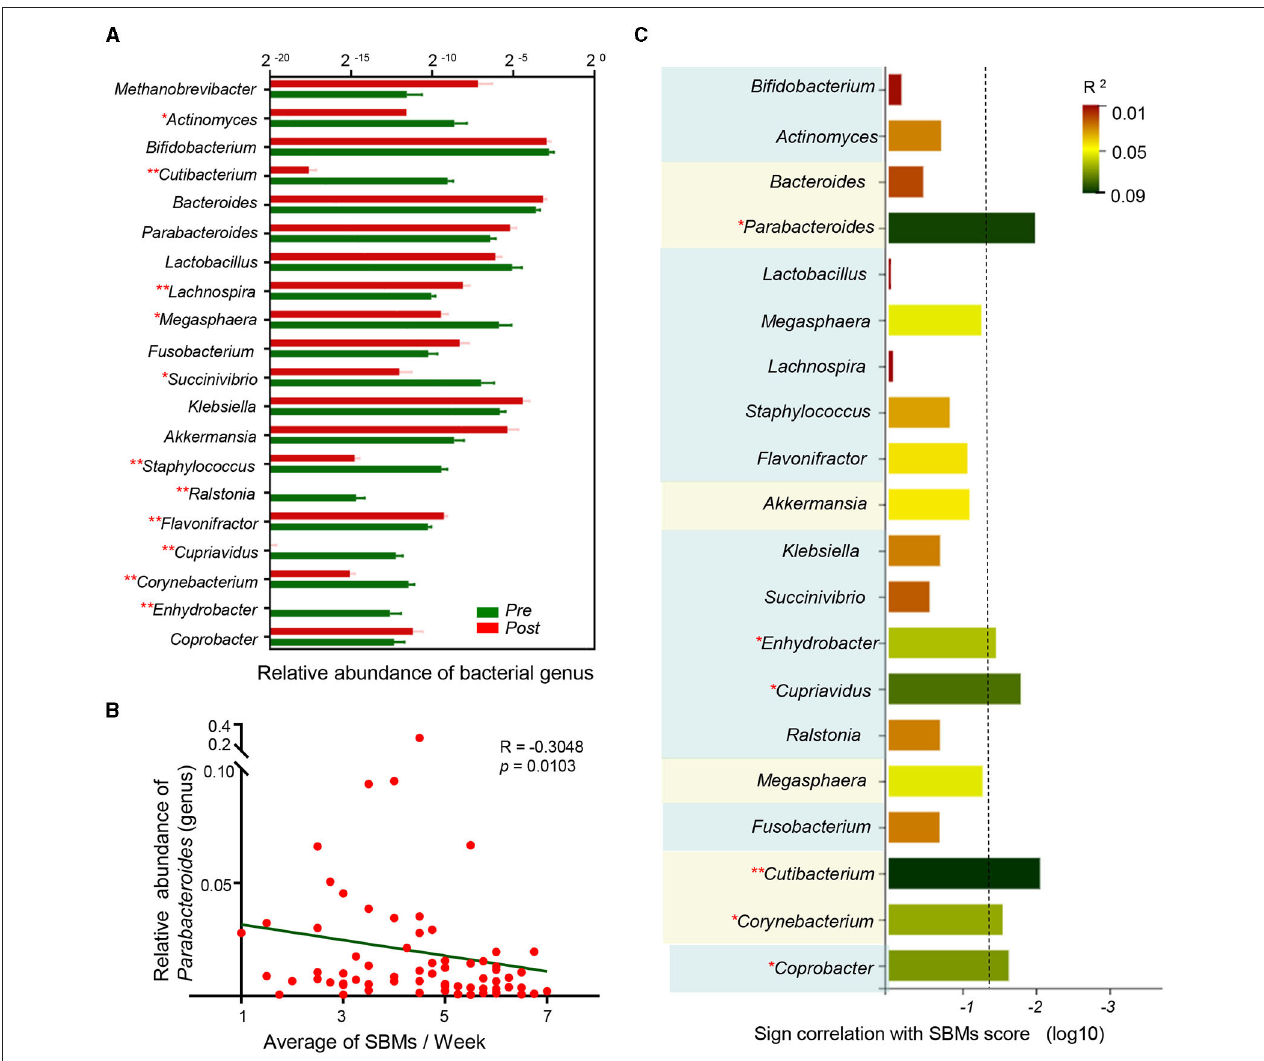
FIGURE 5 | Multiple targets reflect antipsychotic-related constipation severity. (A) Column diagram showed relative abundance of discriminant genera by random forest analysis and LEfSe across two groups. * p < 0.05, ** p < 0.01, permutation test; (B) Spearman correlation between the average of SBMs and relative abundance of Parabacteroides (genus); (C) sign of the Spearman correlation between bacterial taxa and the average of SBMs. Horizontal axis represents the significance of Spearman correlation and the column surpasses the broken line means p < 0.05. Vertical axis represents the taxa include discriminant genera by random forest analysis and the bacterial taxa generated by LEfSe. The taxa belonged to the same phylum have been marked with the same background color. Colors represent the R 2